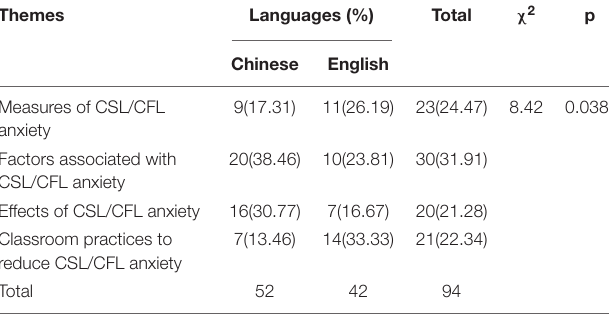
TABLE 2 | The chi-square test result of topical issues in mainland Chinese and international